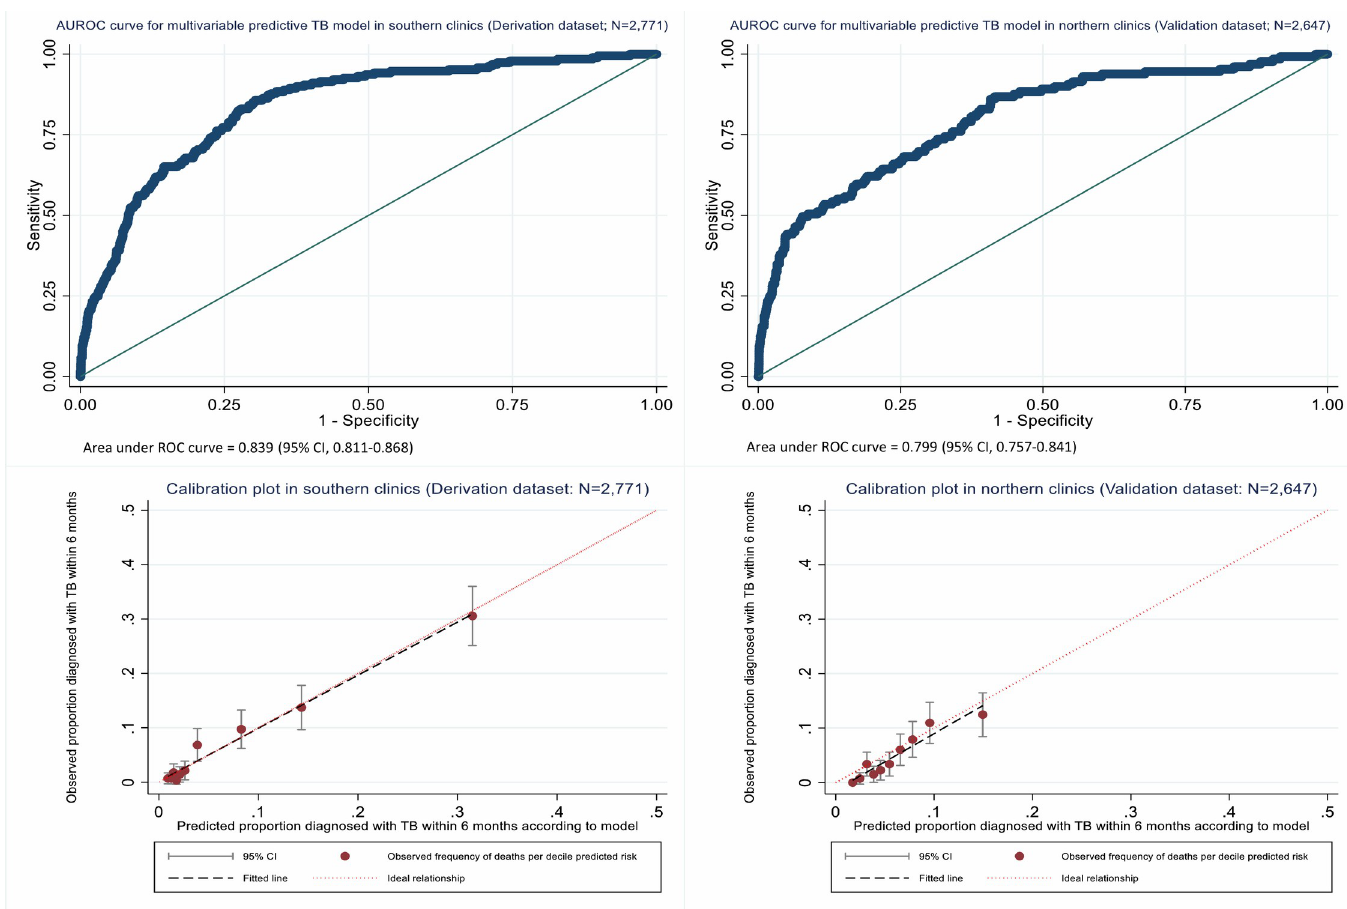
Fig 2. Logistic regression model AUROC curves and calibration curves for the internal derivation and validation datasets, respectively. AUROC, area under the receiver operating characteristic; TB, tuberculosis.